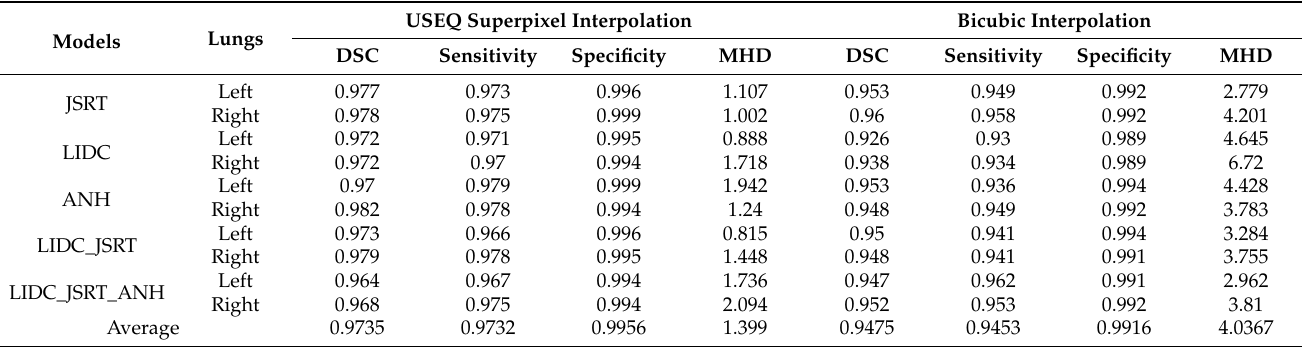
Table 2. Quantitative performance of the segmentation results between USEQ superpixel interpola- tion and bicubic